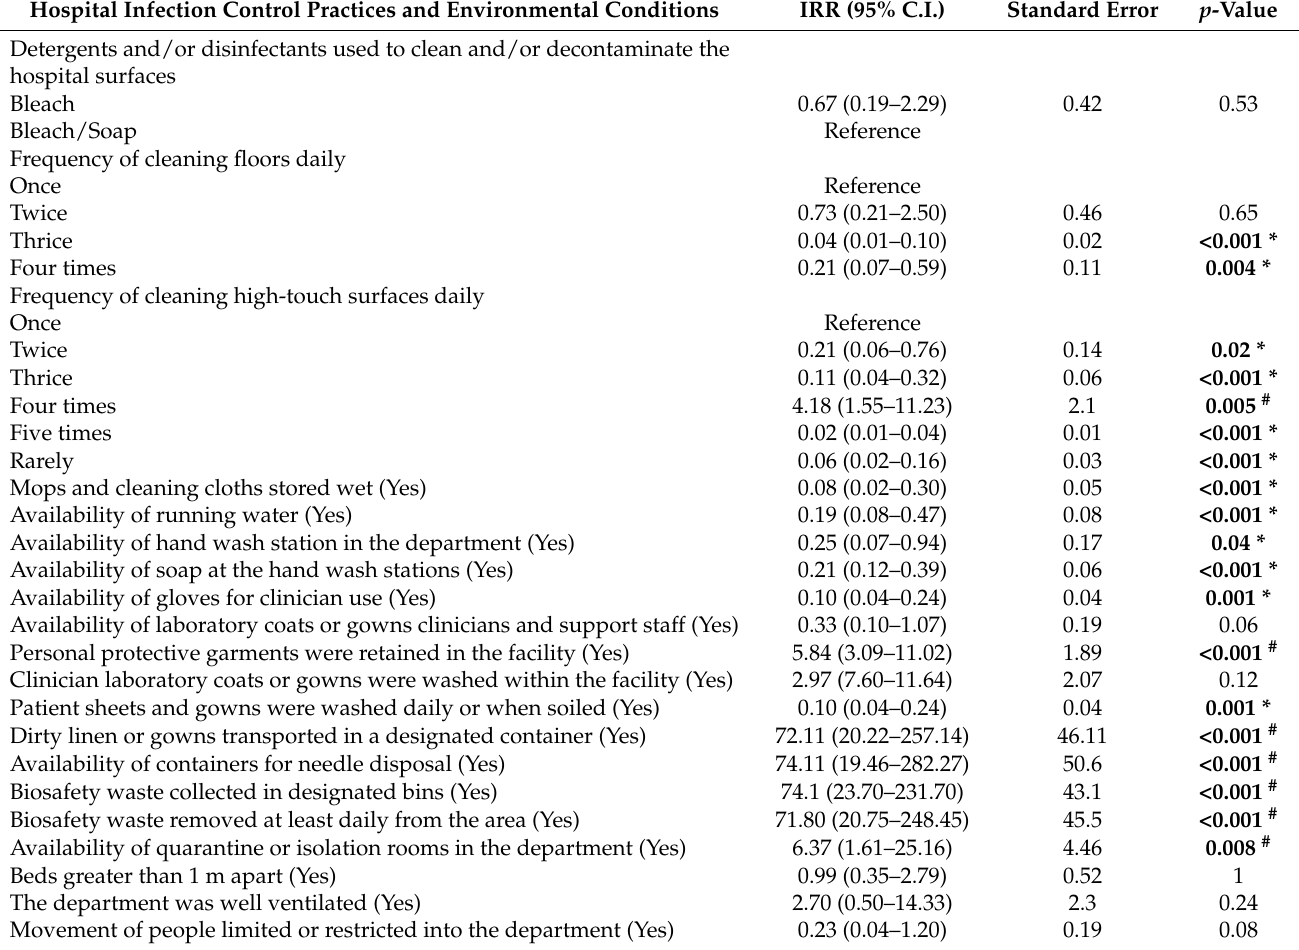
Table 3. Univariate analysis of the influence of hospital IPC practices and environmental conditions on bacterial loads in the study